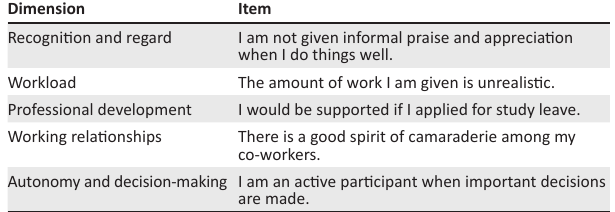
TABLE 3: Example of EM items being